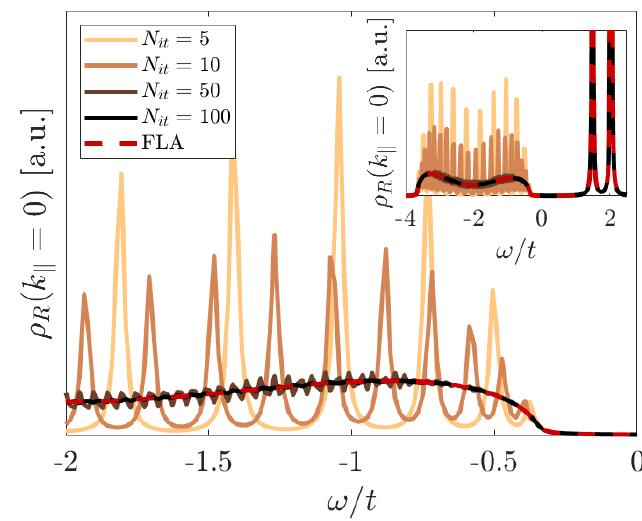
Figure 7: Open right boundary spectral density at k (cid:107) = Γ for the Checkerboard lat- tice model with η = 0.02 and the rest of parameters are the same as in Fig. 6. Solid lines represents the spectral density obtained by recursive GF for different number of = 5,10,50. Dashed red line is obtained using FLA. Main figure: recursive steps N it top continuum valence bands contribution to the spectral density showing the dis- cretization effect of the recursive method. Inset: All the contributions to the spectral density including the flat band at ω/ t = 2 and the topological chiral edge state at ω/ t ≈